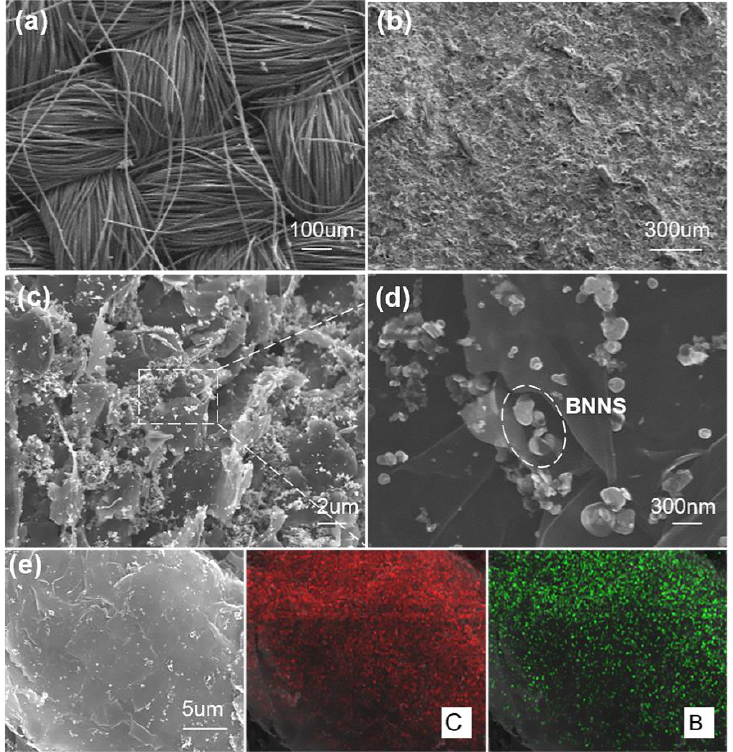
Figure 3. SEM images of the CC/CNT/graphene electrode. ( a ) SEM image of the carbon cloth. ( b ) SEM image of the carbon cloth loaded with CNTs. ( c ) SEM image of the carbon cloth loaded with CNT and graphene. ( d ) The BNNS inserting into layered graphene sheets to prevent collapse. ( e ) SEM images and the corresponding Energy Disperse Spectroscopy (EDS) elemental mapping of ( C , B ) for CC/CNT/graphene electrode.